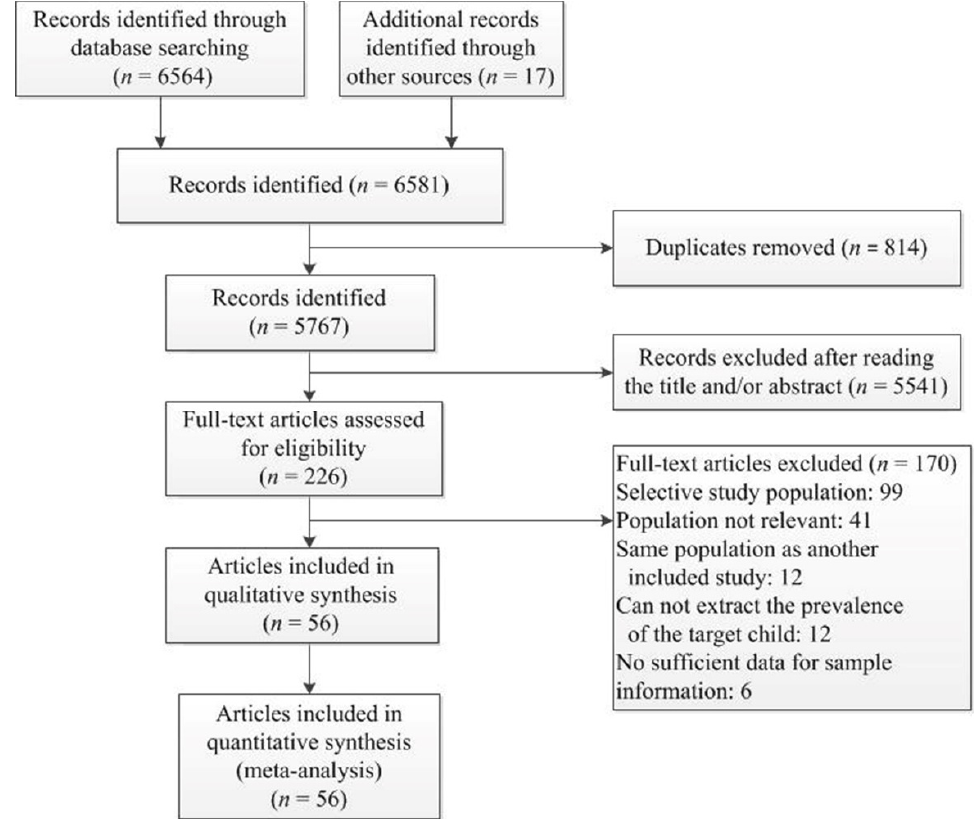
Figure 1. PRISMA flow diagram of literature search and study selection.